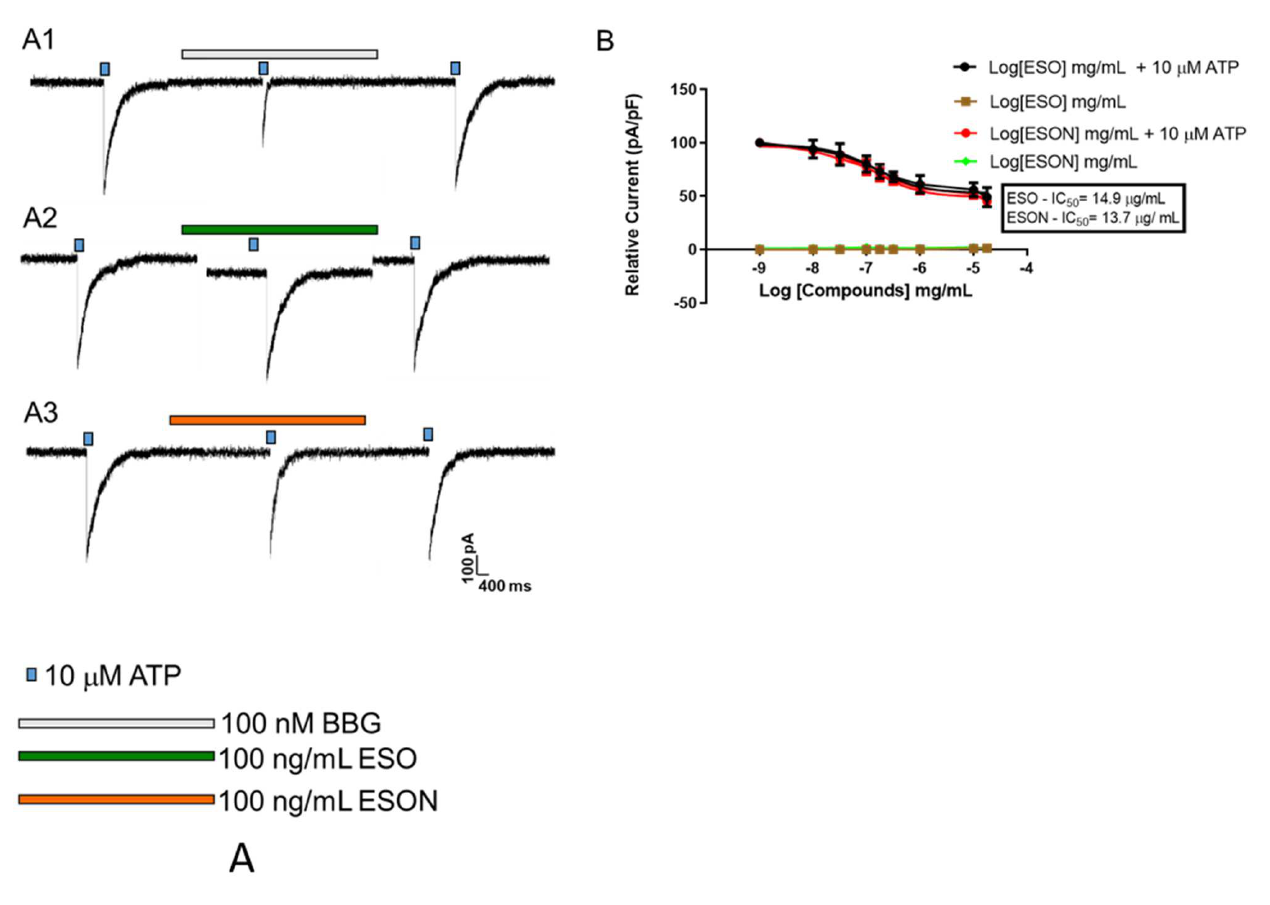
Figure 2. Dose–concentration curves for ESO and ESON inhibition on P2X7R cationic channel activity. ( A ) Whole-cell recordings of the cationic P2X7R activated by 10 µM ATP for 5 s at 30–37 °C on MPM. The reversibility of the inhibitory effect: a pulse of 10 µM ATP followed by perfusion of concentrations of ESO, ESON, or 100 nM BBG. After the washout, another pulse of 10 µM ATP was applied; ( B ) the plot represents the quantification of the data observed in ( A1 – A3 ); % relative current was recorded as a function of the ratio between the amplitude of the ionic current and cell capacitance. In all assays, we added the antagonists before ATP stimulation (1–10 min). Profiles are representative of 4 experiments for whole-cell recordings. p > 0.05 when compared to positive control.